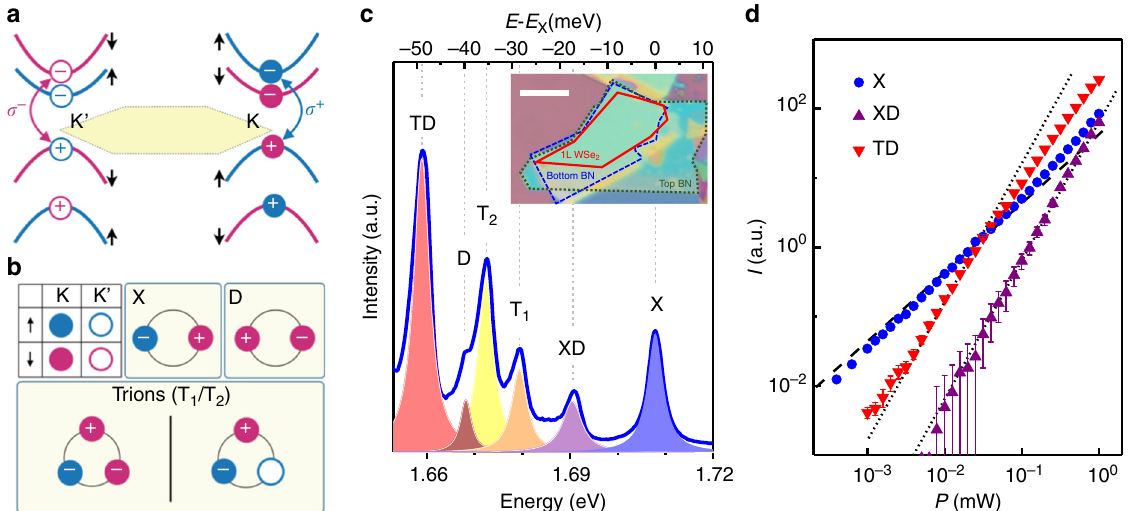
Fig. 1 Multi-particle bound states in 1L-WSe 2. a Conduction and valence band con fi gurations at the K and K ’ valleys. The color for the bands re fl ects the spin of the electron states. b The schematics of valley-spin con fi gurations of bound states. We use blue (red) to denote spin up (down) and closed (open) symbols to represent K (K ’ ) valley. Illustrated are the bright exciton (X), the dark exciton (D) and the negatively charged trions (T 1 /T 2 ). Only states with holes in the K valley upper valence band are shown here. c A typical luminescence spectrum of high-quality 1L-WSe 2 excited by 2.33 eV laser at 4 K. Inset: The OM image of the sandwiched hBN/1L-WSe 2 /hBN heterostructure. The scale bar is 10 μ m. d The power-dependent intensity of X, XD, and TD emissions. The dashed (dot) lines in the fi gure are drawn for P / I P / I 2